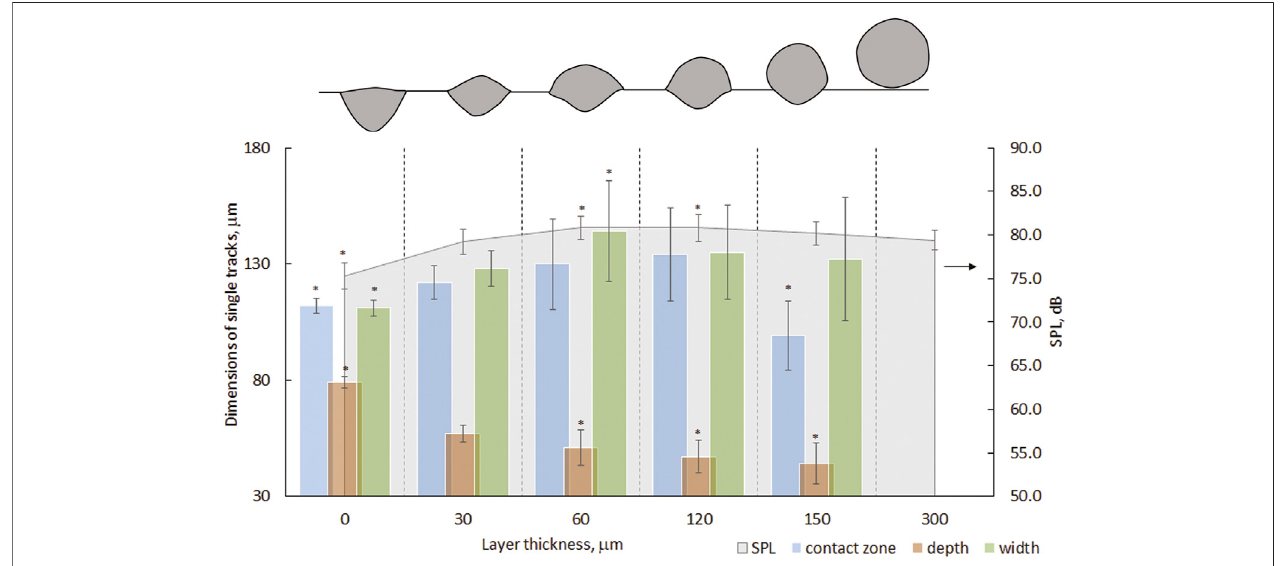
FIGURE 5 | Geometrical characteristics of single tracks at 170 W and 1.2 m/s and the corresponding total sound pressure level in dB referenced to 20 µPa. Statistically signi fi cant differences in average values ( t -test, p < 0.05) in comparison with 30 μ m layer thickness group are indicated by “ * ” ). A schematic model of the evolution of the cross-section of the track with powder layer thickness is shown in the